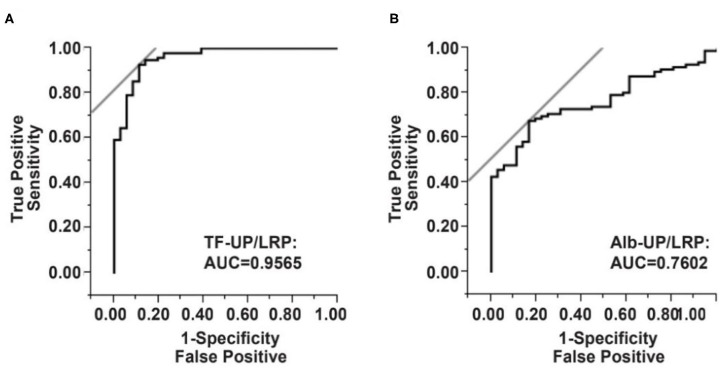
Serum TF-UP level and Alb-UP level as serum biomarkers for acute ischemic stroke, compared with brain tumor-stroke mimics (BT-SM) patients. Receiver operator characteristic (ROC) curve demonstrates sensitivity as a function of 1-specificity to confirm the presence of ischemic stroke by TF-UP/LRP ratio (A) or Alb-UP/LRP ratio (B). TF-UP, transferrin unique peptide; LRP, labeled reference peptide; Alb-UP, albumin unique peptide; AUC, area under the curve.